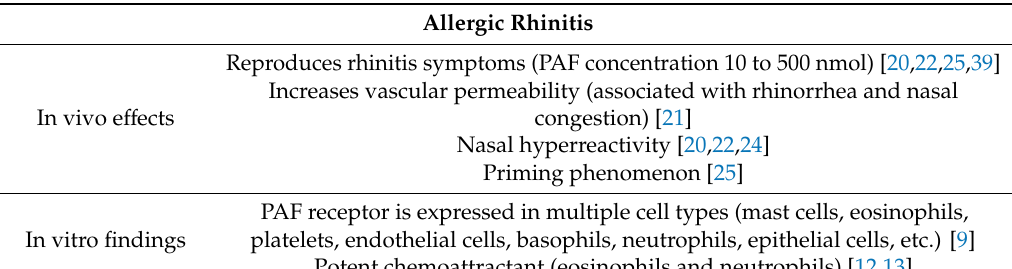
Table 1. PAF in allergic